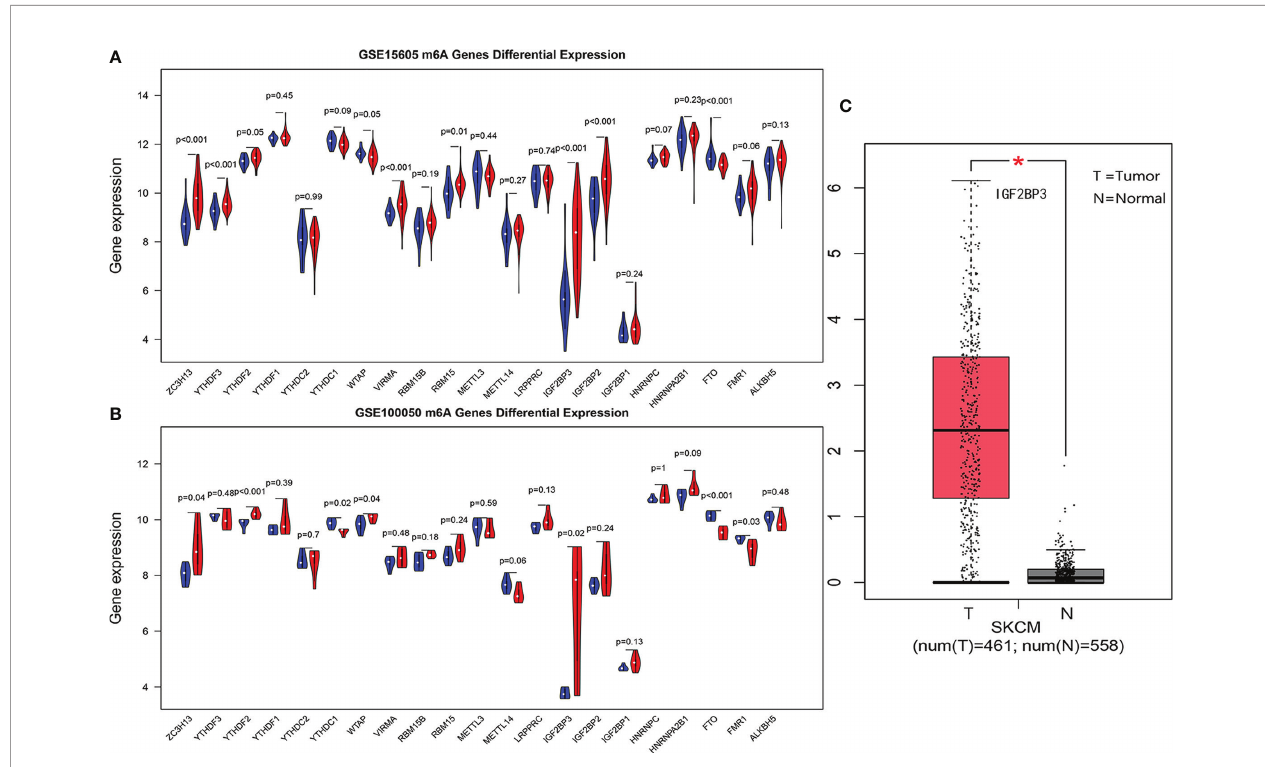
FIGURE 1 | (A, B) are violin diagrams of GSE15605 and GSE100050 (red is the cancer group, blue is the normal group). (C) Expression of IGF2BP3 in skin melanoma and normal tissue in TCGA and GTEX data, where *P <